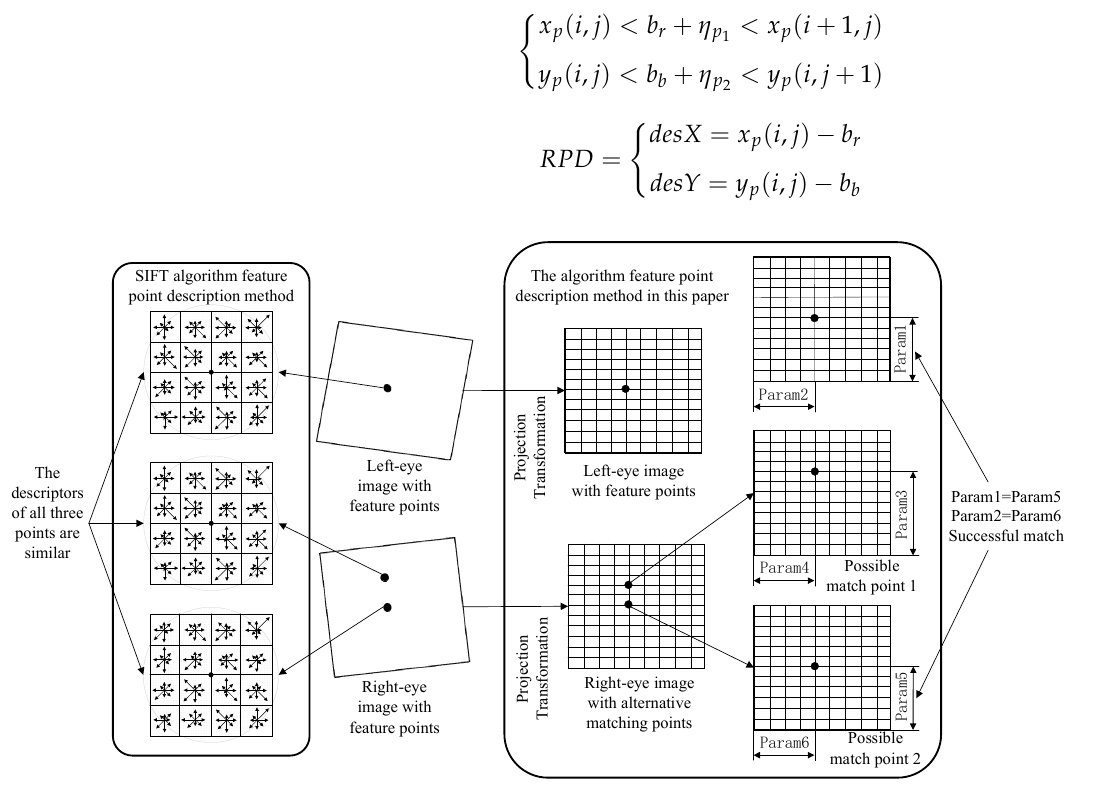
Figure 8. Comparison of feature point description methods.